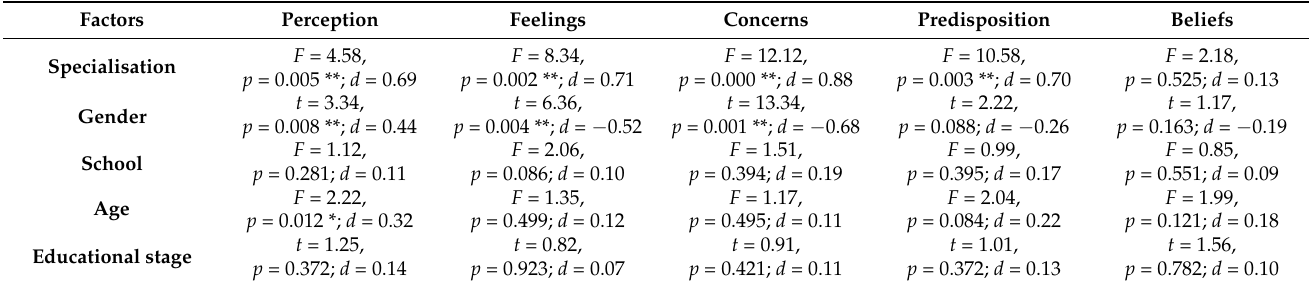
Table 3. Differences according to independent variables (specialisation branch, gender, school, age and educational stage).